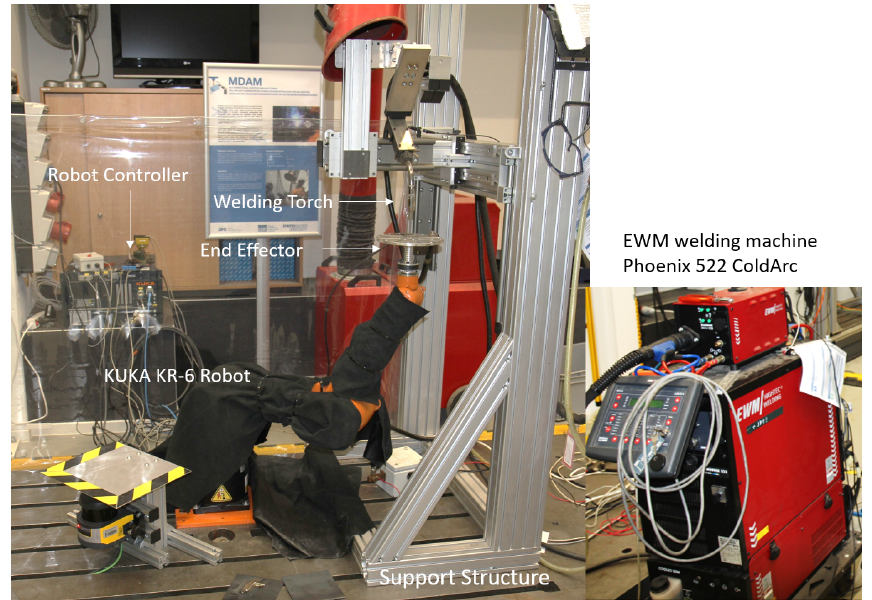
Figure 6. Robotic setup constructed at the IGMR